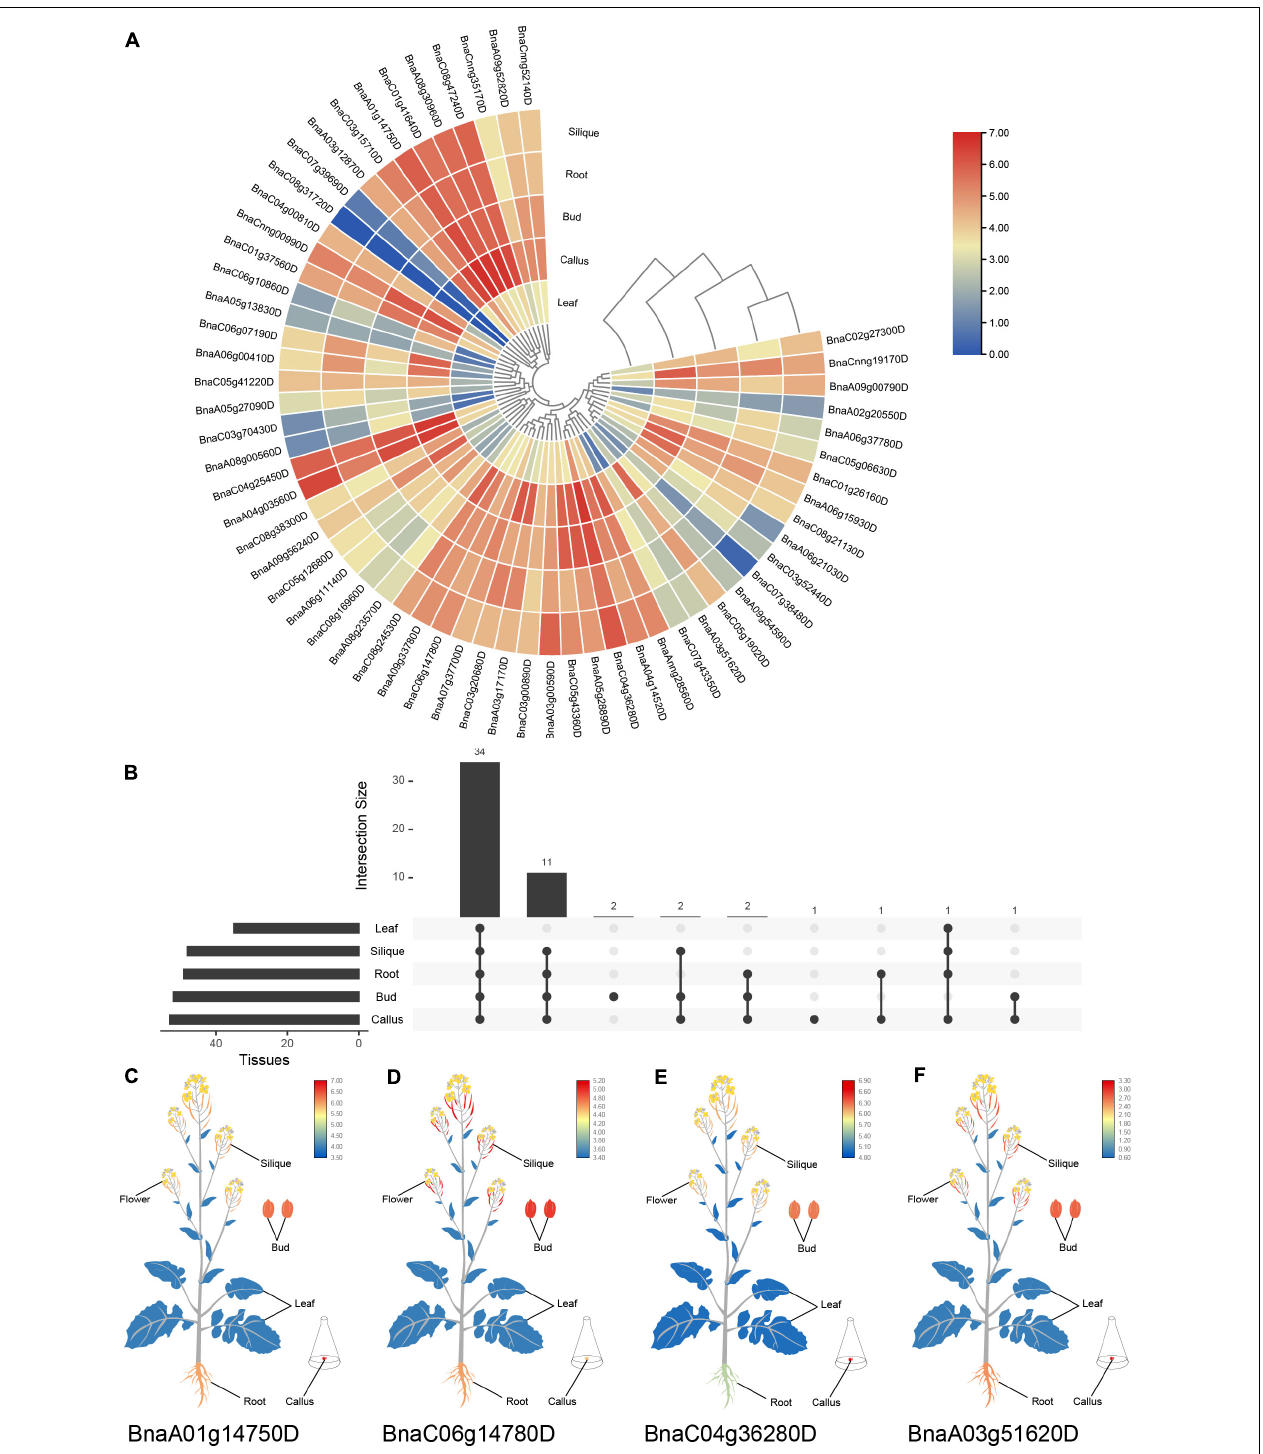
FIGURE 6 | Expression profiles of SR genes in different tissues of B. napus . (A) Heatmap representation of 59 SR genes in different tissues. (B) Number of SR genes that were expressed in various tissues. (C–F) The expression patterns of four selected SR genes in B. napus plants. Expression data were processed with log 2 normalization. The color scale represented relative expression levels from low (blue color) to high (red color).